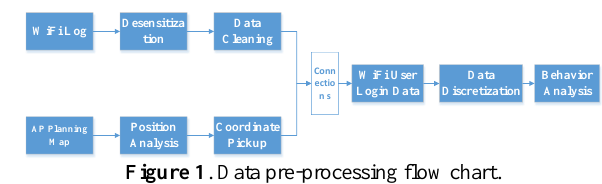
Figure 1 . Data pre-processing flow